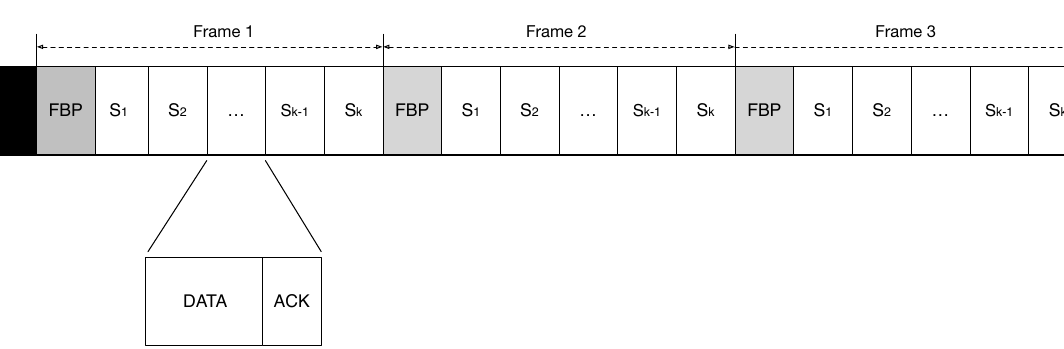
Figure 1. Frame Slotted ALOHA (FSA) time organization. The black square in front of the first frame represents the protocol used to wake-up and synchronize the